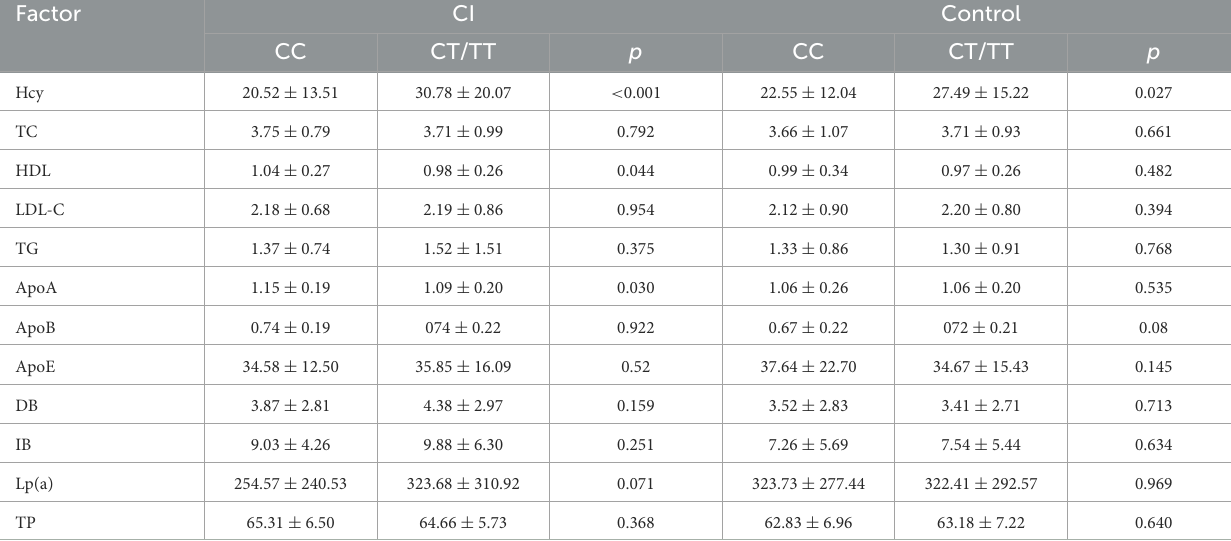
TABLE 5 Relationships between serum lipid profiles and MTHFR C677T polymorphism among CI patients and control participants. Factor CI Control CC CT/TT